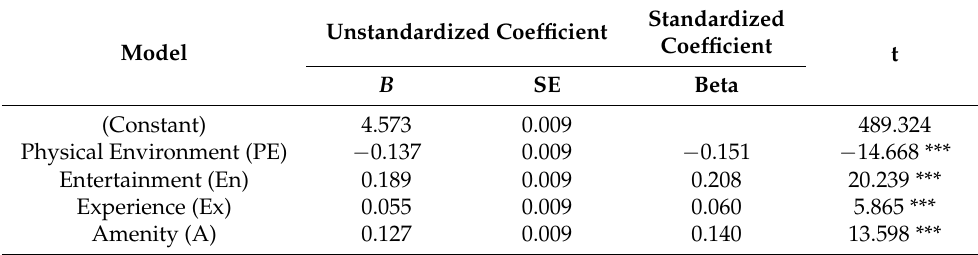
Table 8. Results of linear regression analysis (The Venetian in Las Vegas).